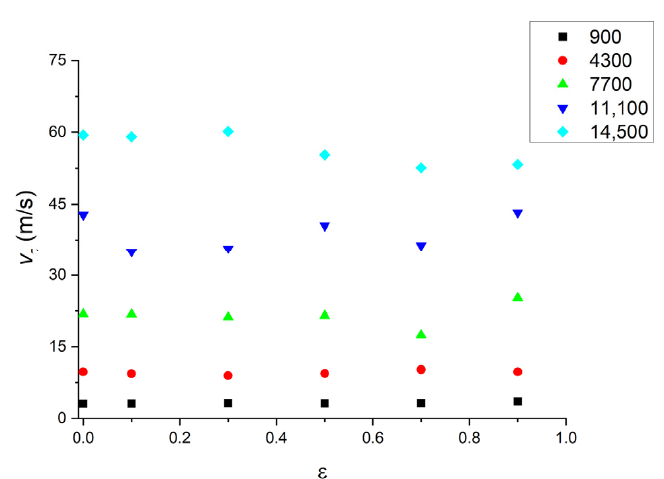
Figure 6. Average value of tangential speeds ( v τ ) of fluid (Unit: m/s).